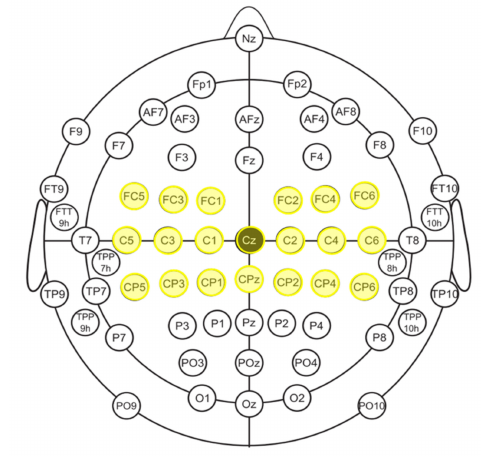
Figure 7. The electrode